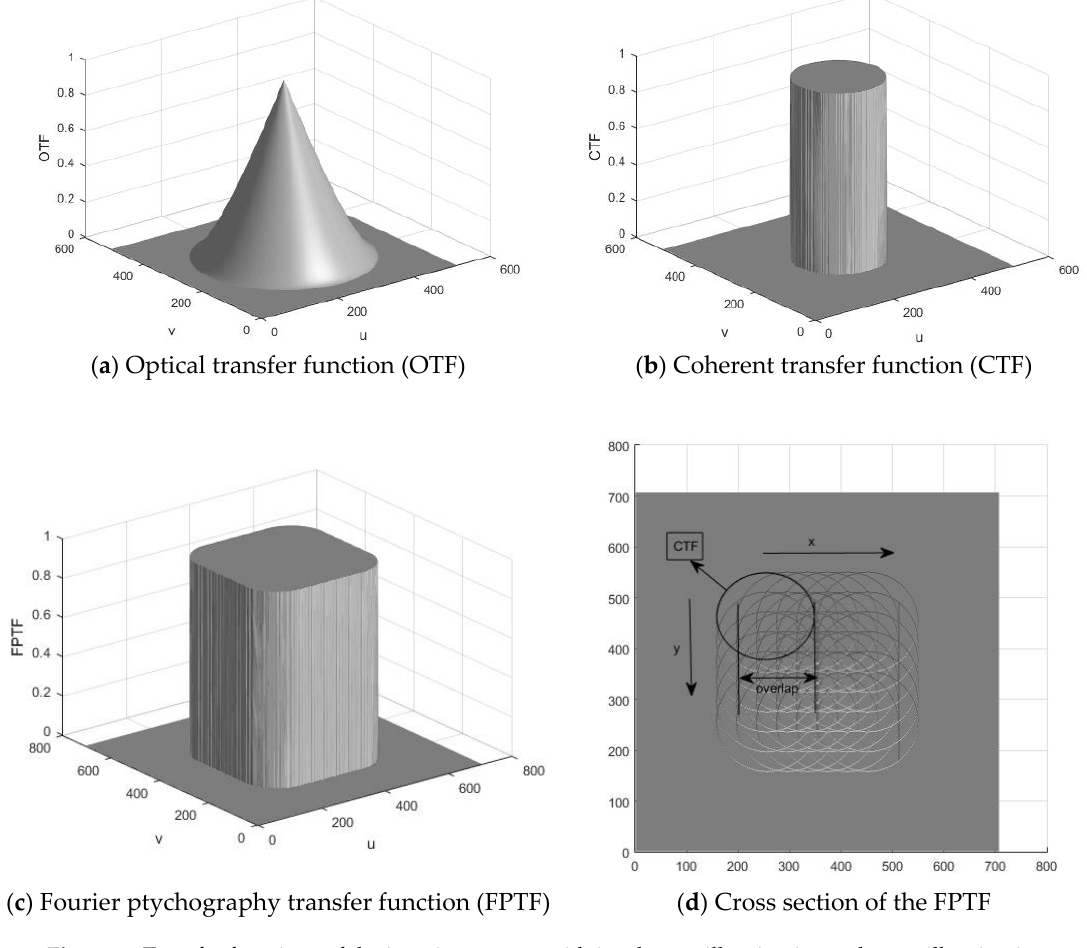
Figure 1. Transfer functions of the imaging system with incoherent illumination, coherent illumination and macroscopic Fourier ptychography, respectively.